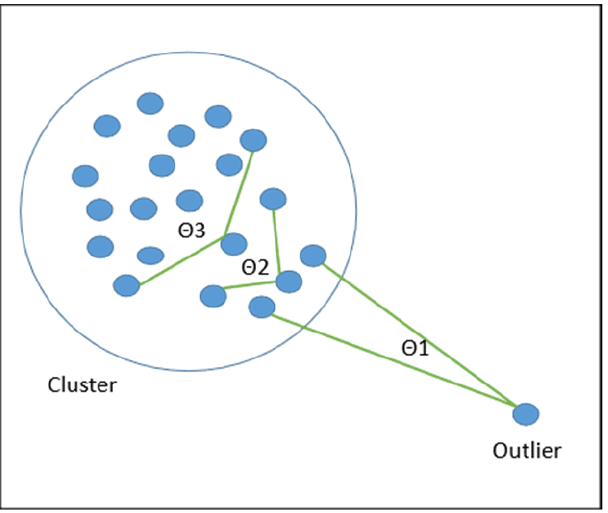
Figure 7. An outlier has low variance in its angle with other data points as compared to an inlier.